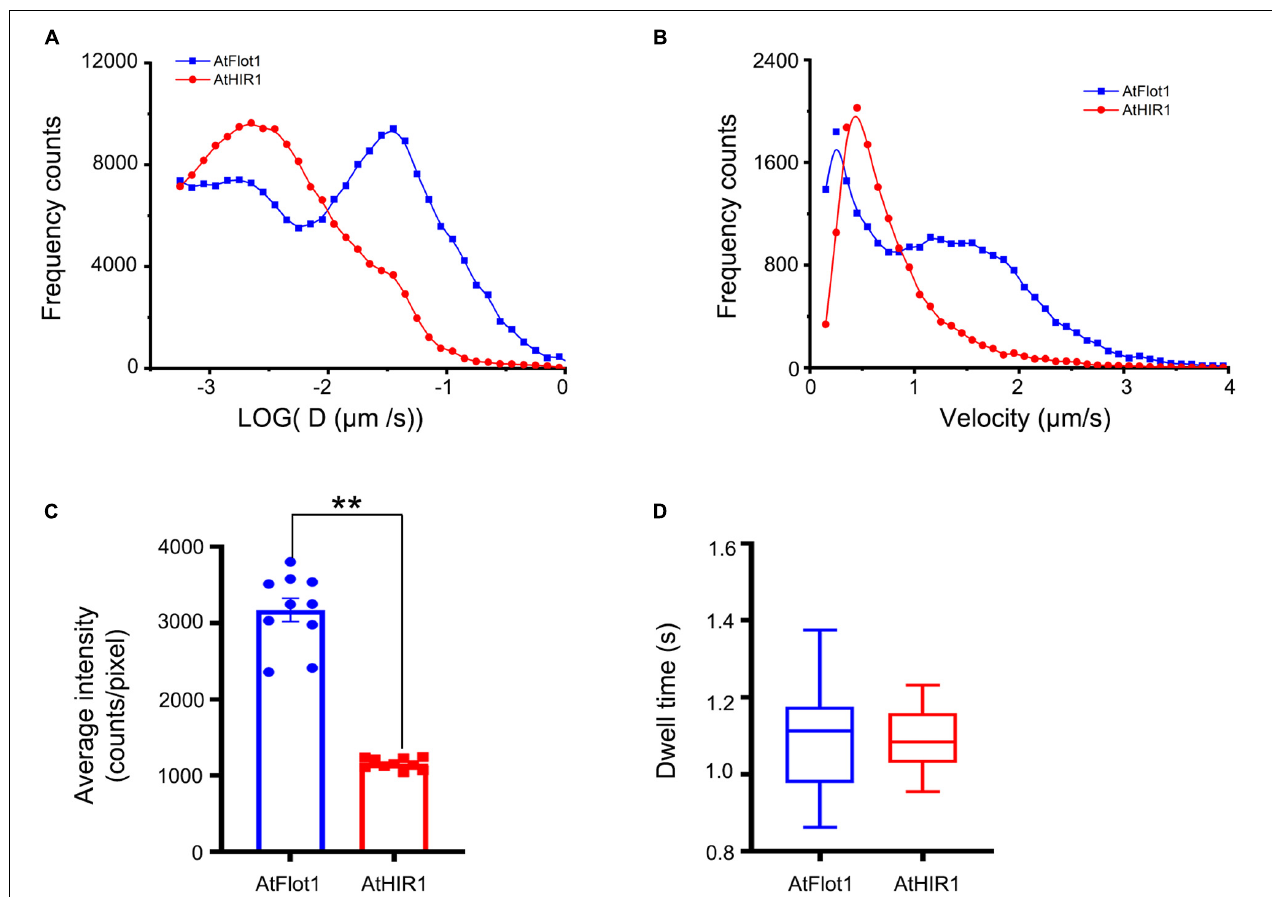
FIGURE 3 | Assessing AtFlot1 and AtHIR1 protein mobility by TIRFM analysis. (A) Distribution of the diffusion coefficients of AtFlot1 (blue, n = 1892) and AtHIR1 (red, n = 2513) in living leaf epidermal cells. (B) Distribution of the velocity of AtFlot1 (blue, n = 2243) and AtHIR1 (red, n = 1954) in living leaf epidermal cells. (C) Average fluorescence intensity of GFP-AtFlot1 and AtHIR1-GFP. For each examination, at least 10 cells from each of five seedlings were examined. In each case, three biological replicates were performed. Statistical significance was determined using Student’s t -tests (** P < 0.01). (D) Dwell times were analyzed in GFP-AtFlot1 and AtHIR1-GFP plants. For each examination, at least 30 cells from each of five seedlings were examined. In each case, three biological replicates were performed. Statistical significance was determined using Student’s t